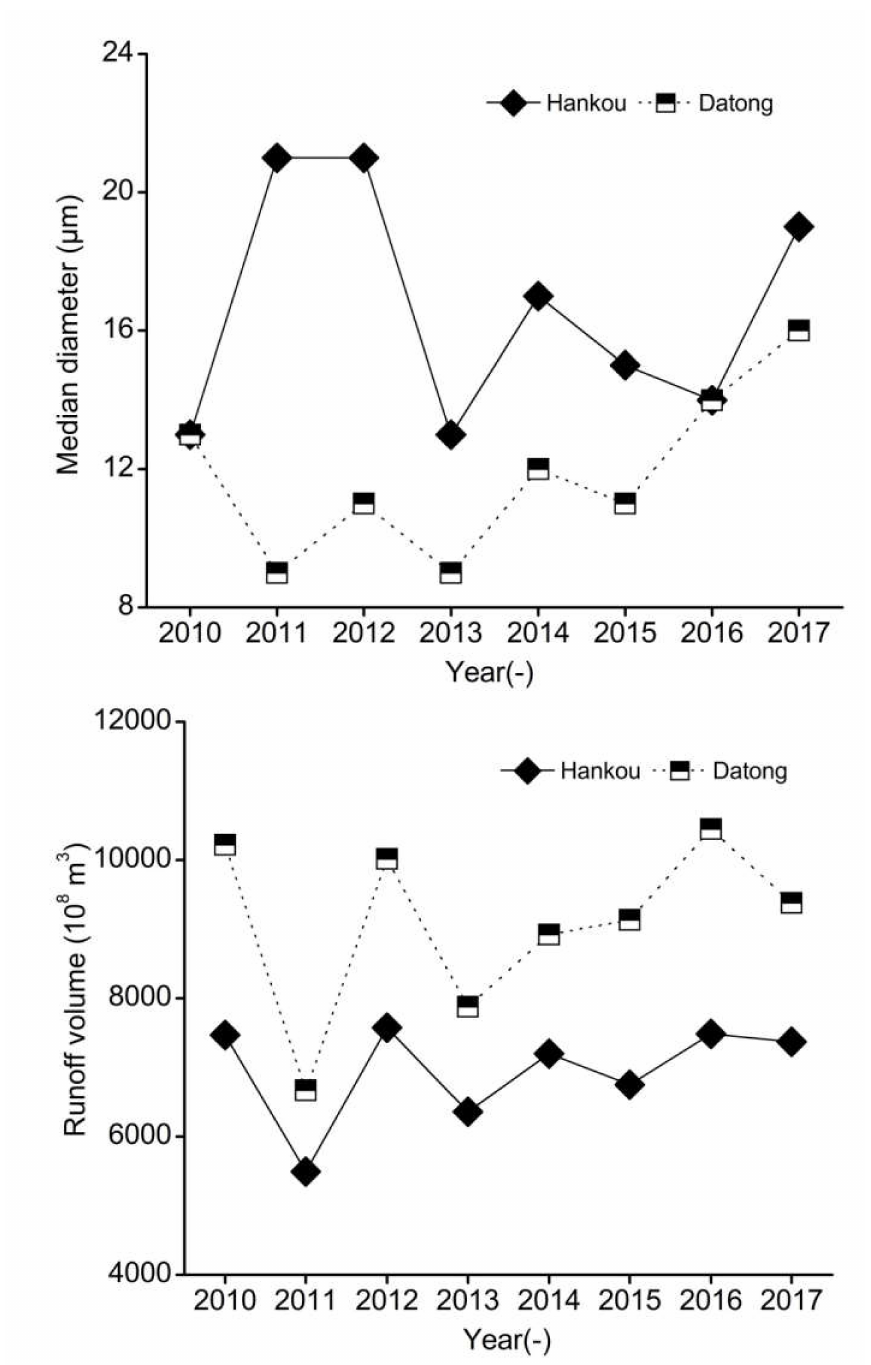
Figure 9. Variation in the annual mean median particle size of SS and total runo ff volume between 2010 and